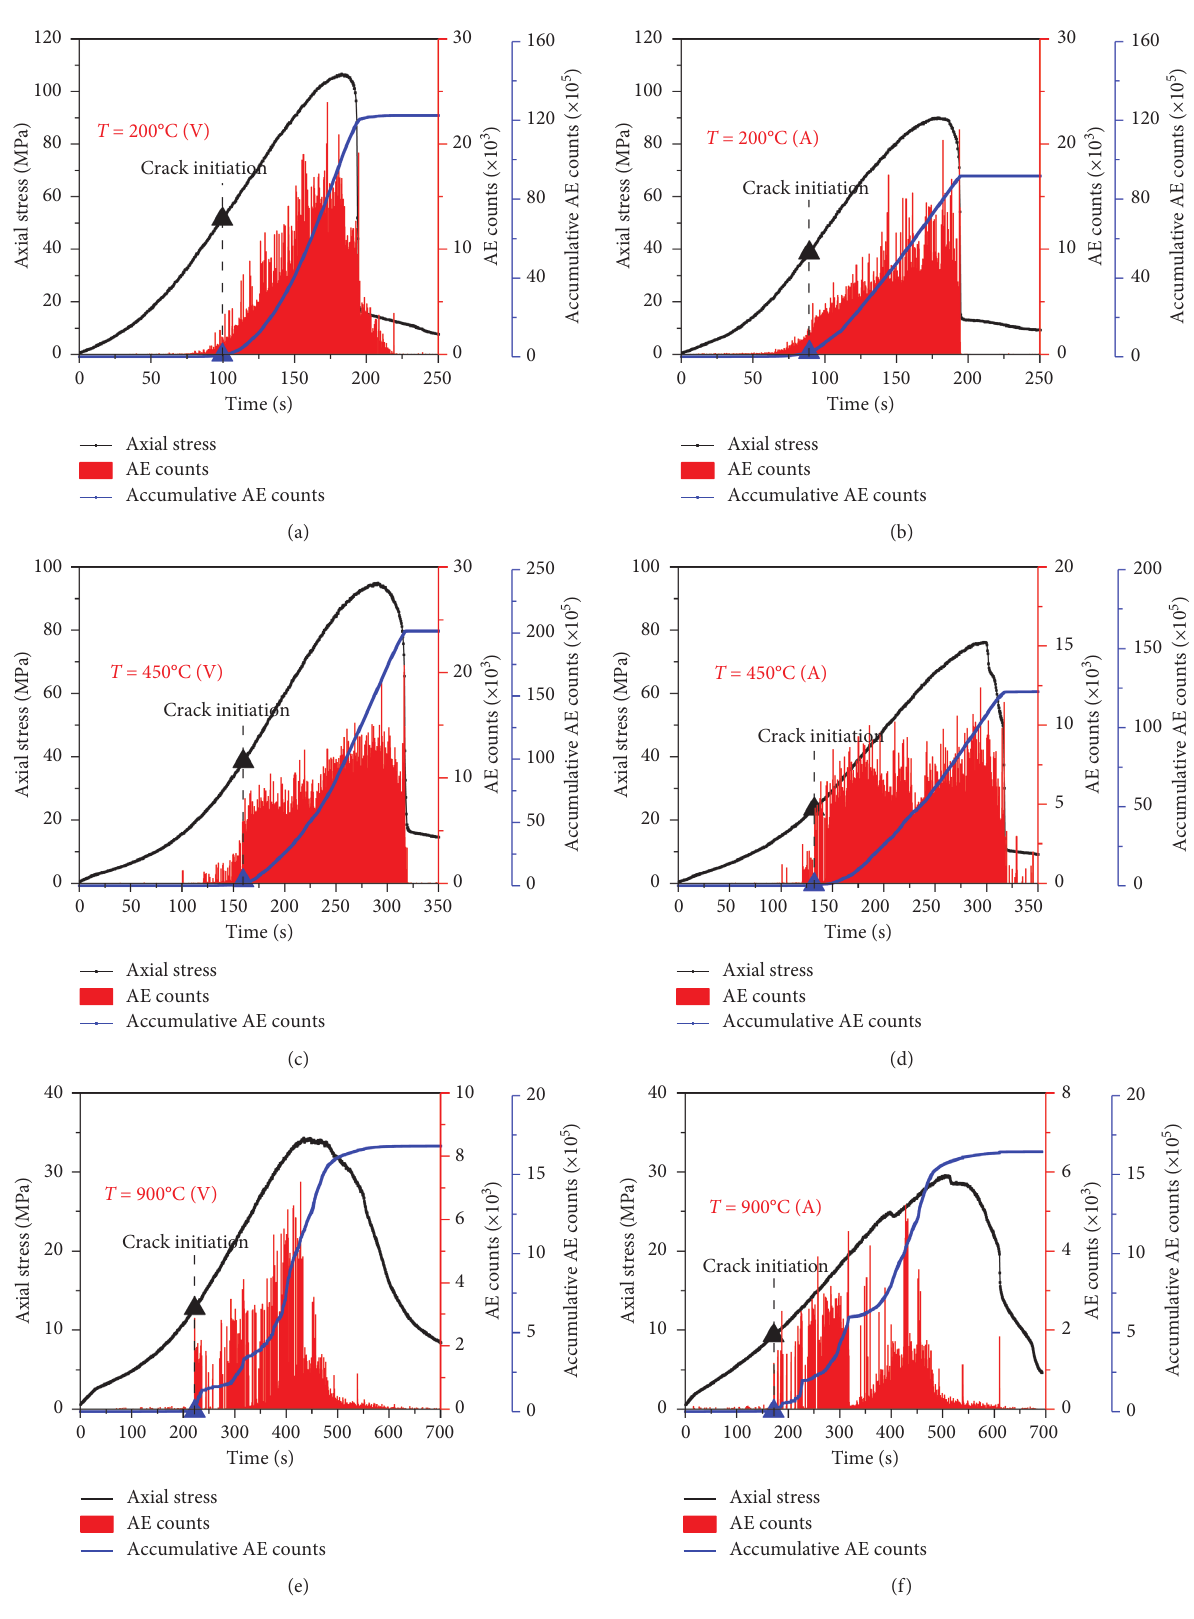
Figure 9: AE curves of limestone specimens under uniaxial